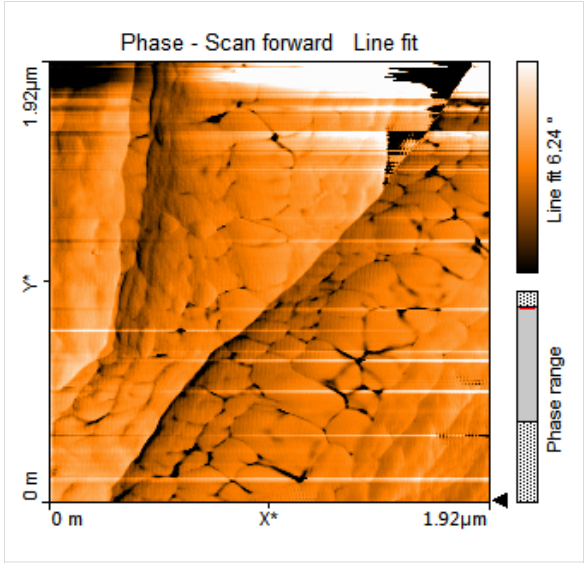
Figure 9: AFM image of GO-containing oxidized PAN nanofiber